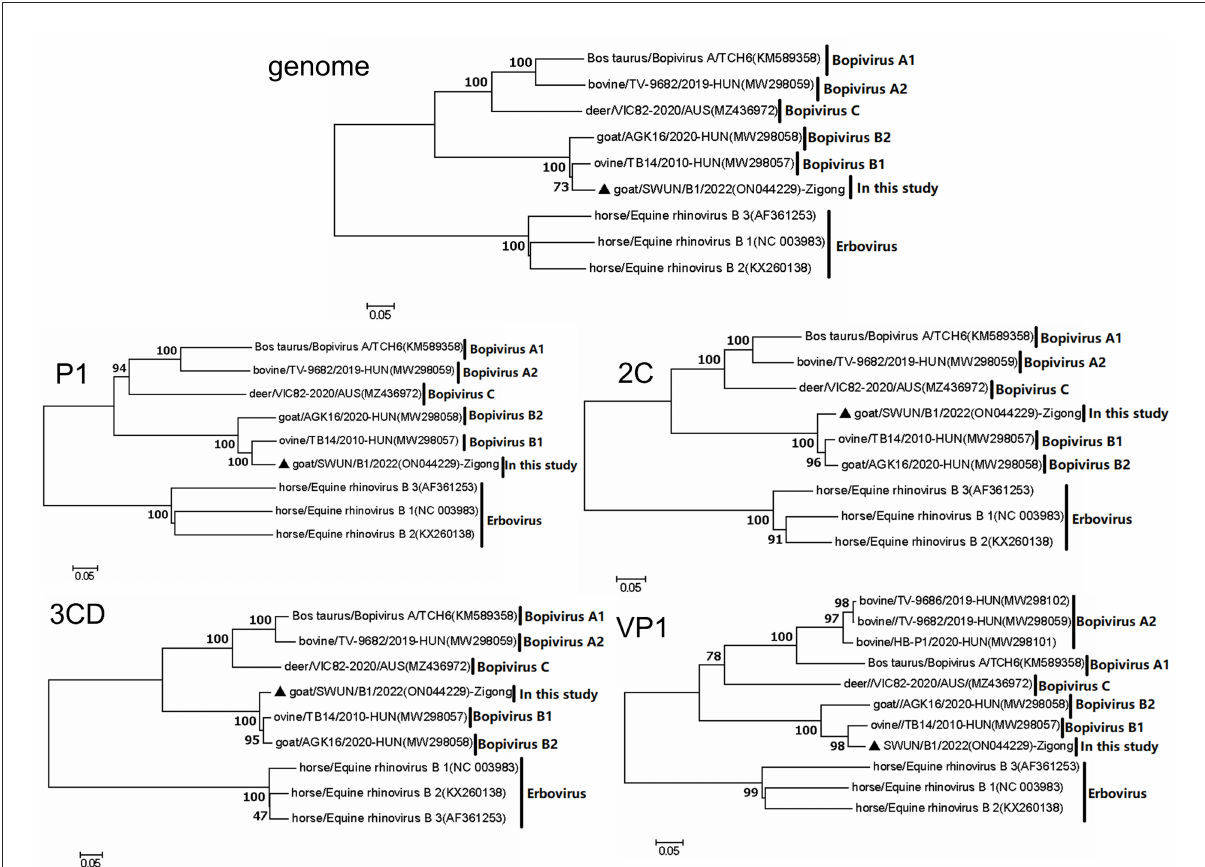
FIGURE4 Phylogenetic relationship of bopiviruses from this study with representative members from genus Bopivirus based on nt similarity of the P1, 2C, 3CD, VP1, and complete genome. The trees were constructed using the neighbor-joining method in MEGA 7.0 program. The bootstrap values were calculated from 1,000 replications. The black triangles indicate that the corresponding sequences were from the strains in this study.